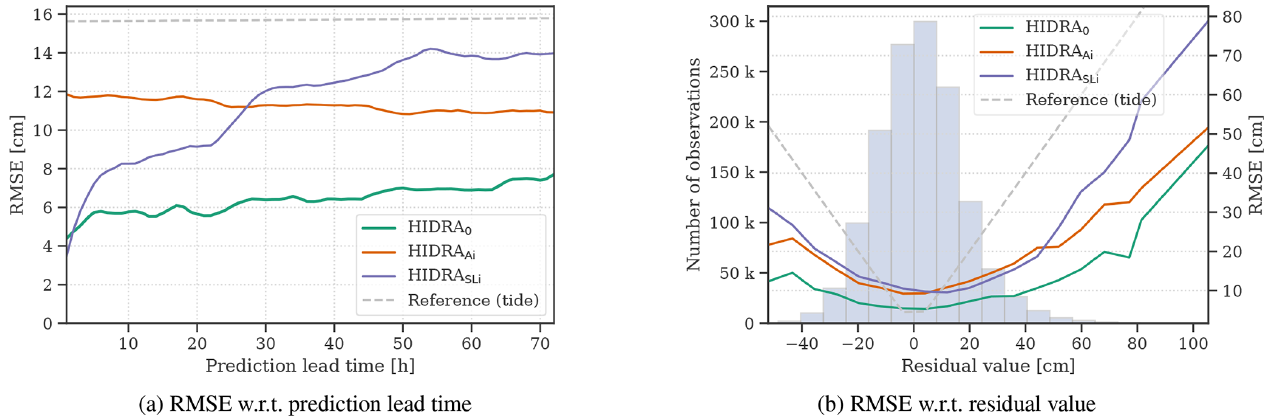
Figure 5. Performance of single-input-source models. Root mean square error (RMSE) with respect to (a) prediction lead time and (b) resid- ual value bins for different input sources is visualized. The full HIDRA model is compared with single-input-source variants – atmospheric data only HIDRA Ai model and tidal data only HIDRA SLi model. The RMSE of the astronomic tide is shown for reference.